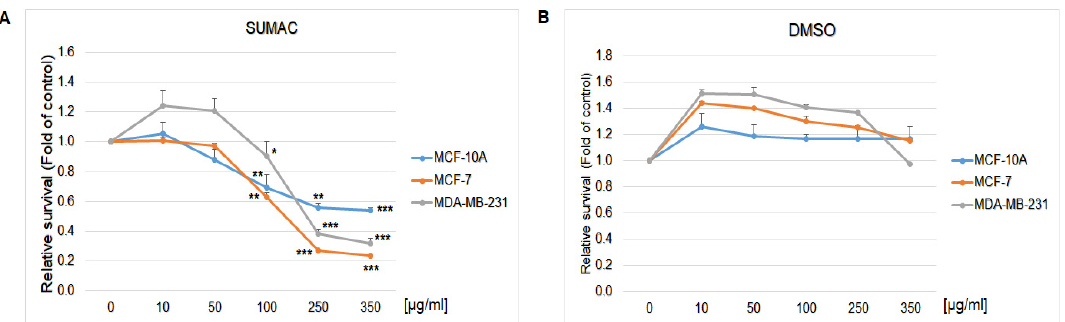
Figure 9. Relative survival of MCF-7, MDA-MB-231, and MCF-10A cells treated with ( A ) SUM (10–350 µg/mL) or ( B ) DMSO vehicle and analyzed by resazurin metabolic assay. Data were obtained from three independent experiments and significant differences were marked as * p < 0.05, ** p < 0.01, *** p < 0.001, vs. control cells (untreated).